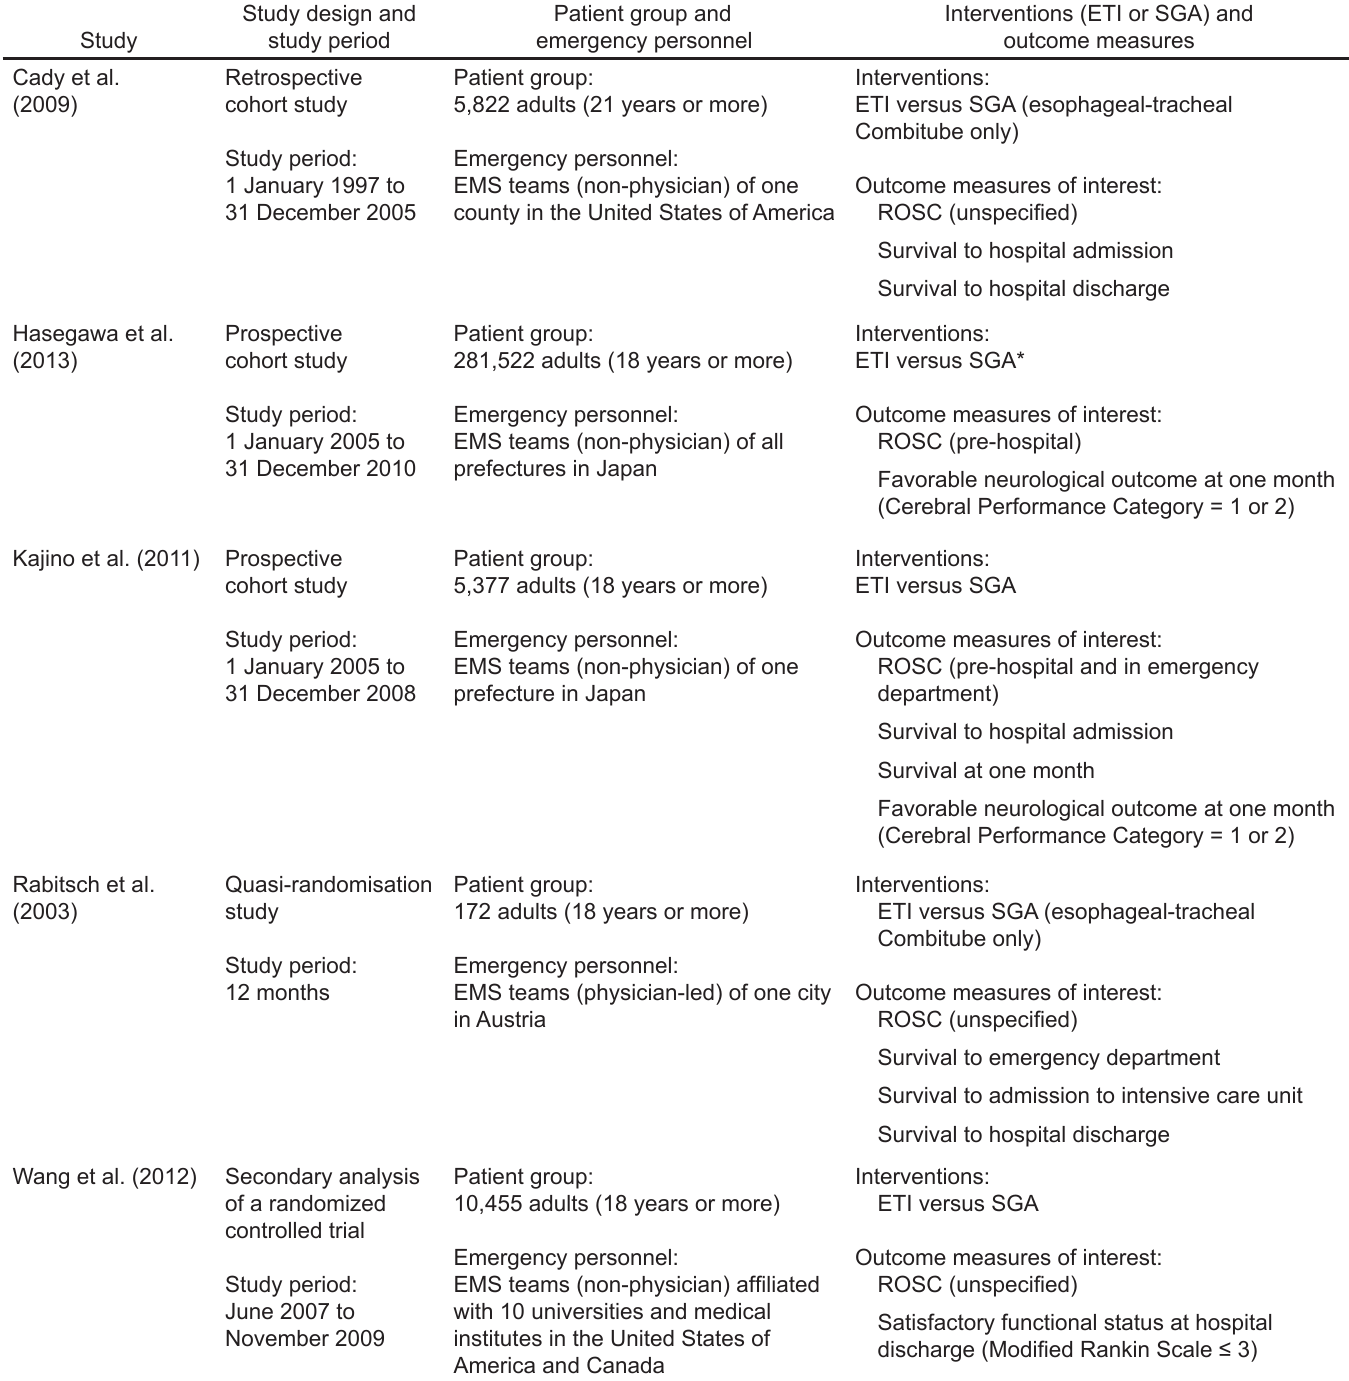
Table 1 . Included studies comparing endotracheal intubation (ETI) with supraglottic airways (SGA): Summary of study